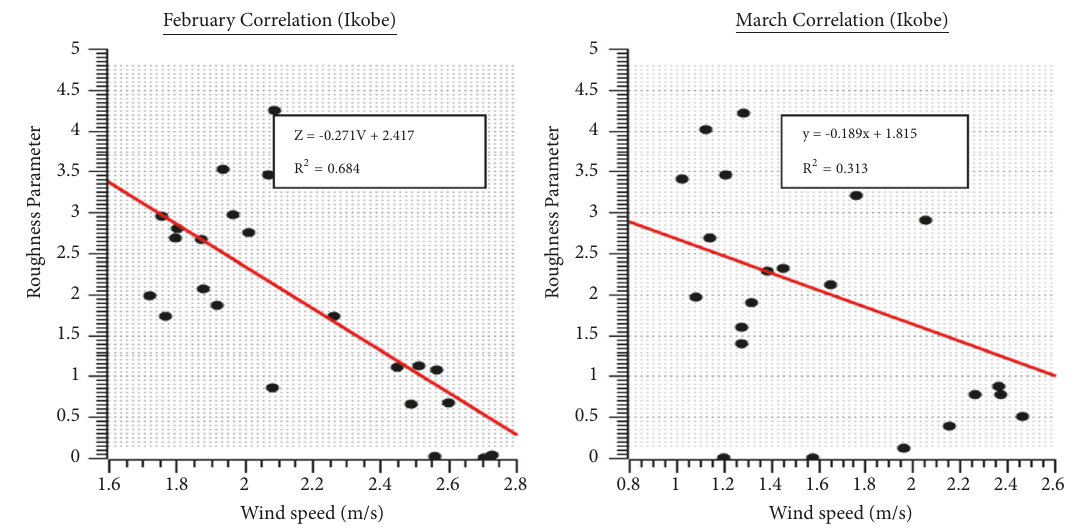
Figure 12: Correlation of wind speeds and roughness parameter for